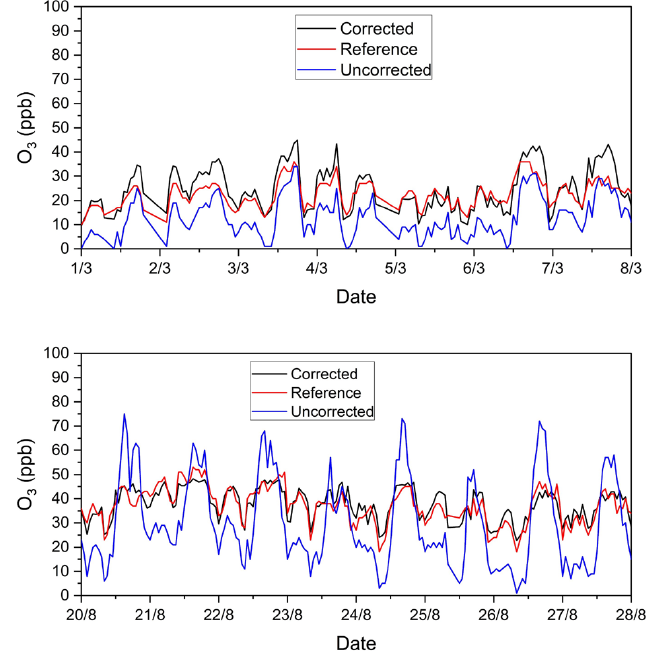
Figure 6. ( a ) Uncorrected O 3 sensor readings versus the observed reference NO 2 concentration, ( b ) RF-corrected O 3 sensor readings versus the observed reference O 3 concentration. Both diagrams re- fer to the test year (2022).